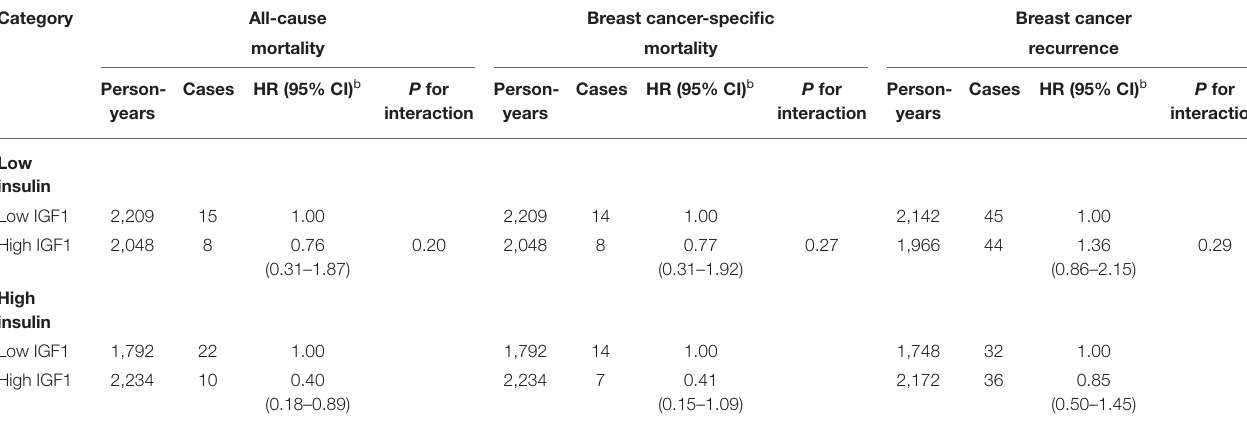
TABLE 3 | Interactions between IGF1 and insulin on all-cause mortality, breast cancer-specific mortality, and breast cancer recurrence a . Category All-cause Breast cancer-specific Breast cancer mortality mortality recurrence Person- Cases HR (95% CI) b P for years interaction years interaction years